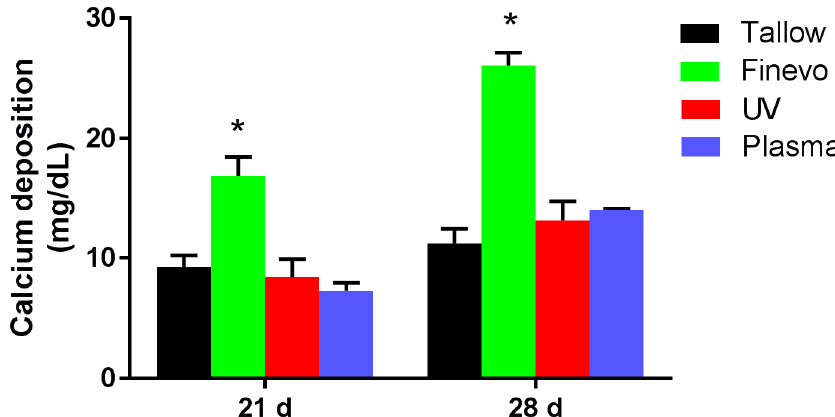
Figure 8. Quantification of calcium deposition, a marker for extracellular matrix mineralization, after differentiation for 21 and 28 d, in each group. Finevo-Ti showed highest calcium deposition at 21 and 28 days. The calcium deposition on Tallow-Ti, Plasma-Ti, UV-Ti at 21 and 28 days decreased as shown in the figure. Black: Tallow-Ti, Green: Finevo-Ti, Red: Plasma-Ti, Blue: UV-Ti. (* p <0.05)